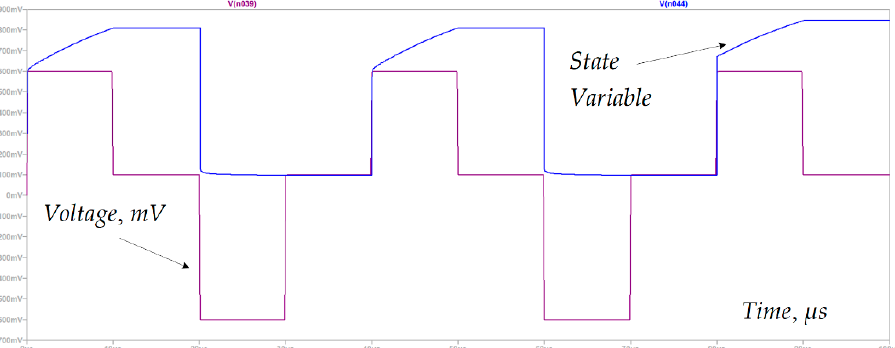
Figure 9. Time diagrams of memristor voltage and state variable derived during the process of writing, reading, and erasing information in the memristor memory crossbar. Electronics 2021 , 10 , x FOR PEER REVIEW